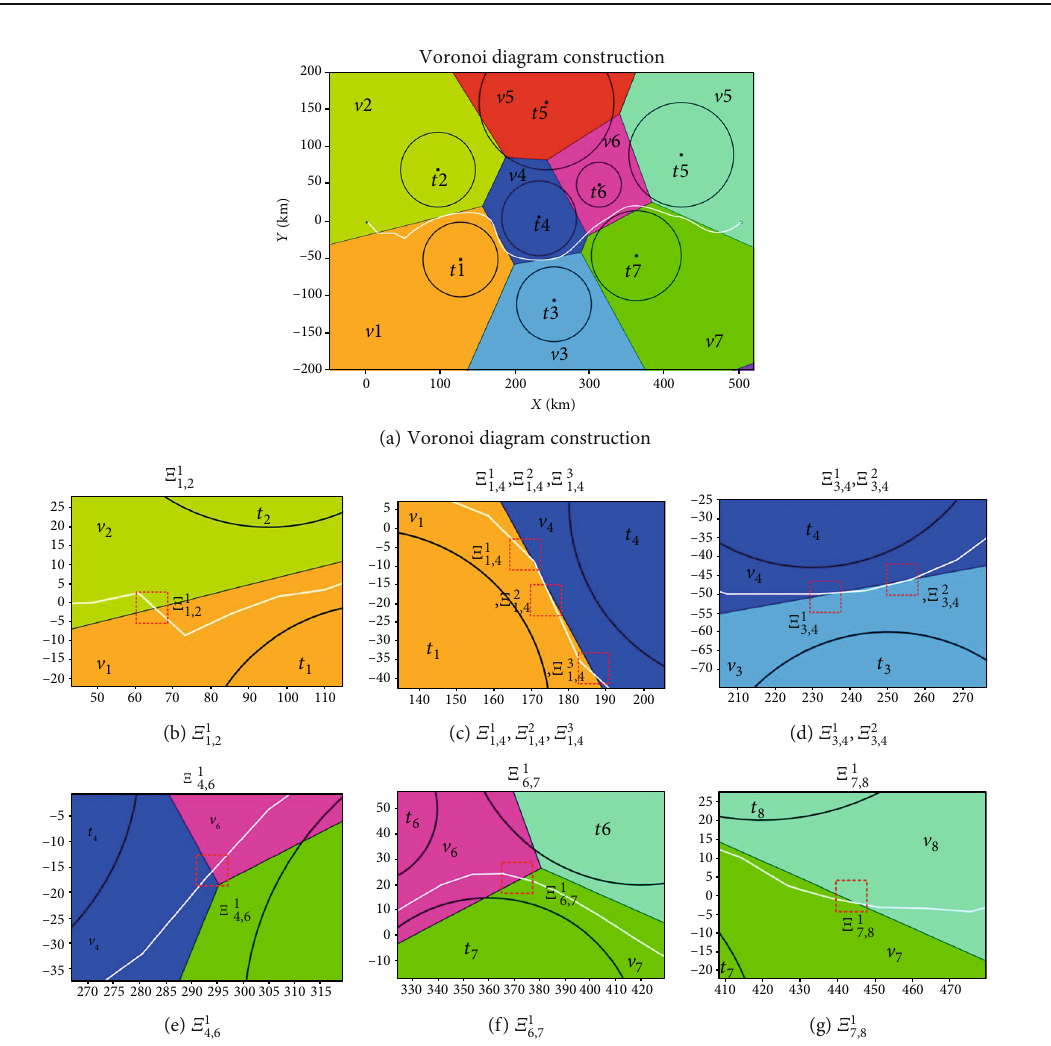
Figure 21: Threat space division.